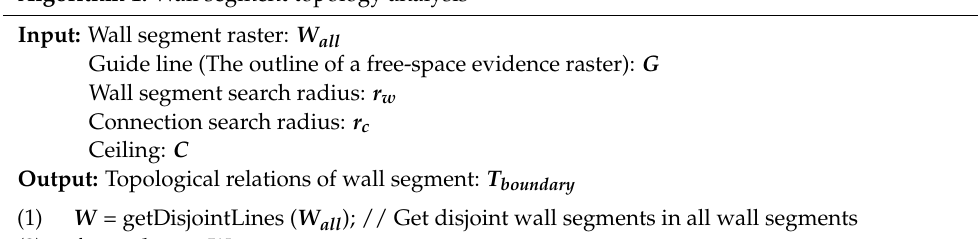
Algorithm 1. Wall segment topology